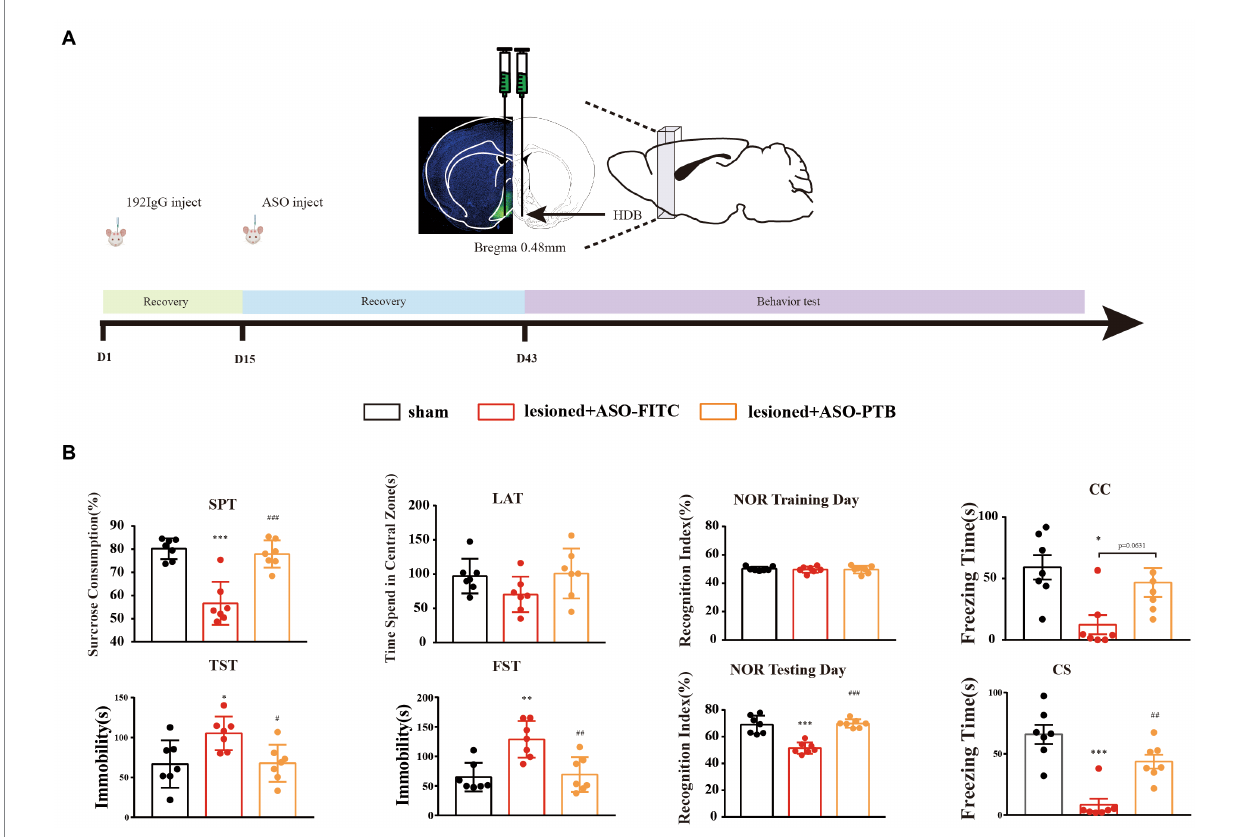
FIGURE 1 Conversion of astrocytes to neurons by ASO-PTB could relieve depressive-like behaviors and ameliorate cognition impairment phenotypes. (A) Experimental schedules. (B) The sucrose preference (one-way ANOVA, Tukey’s multiple comparisons test, F (2,18) = 25.26, *** p < 0.001, ### p < 0.001, n = 7); immobility time in the TST (one-way ANOVA, Tukey’s multiple comparisons test, F (2,18) = 5.42, * p = 0.0254, # p = 0.0293, n = 7) and FST (one-way ANOVA, Tukey’s multiple comparisons test, F (2,18) = 11.05 ** p = 0.0015, ## p = 0.0027, n = 7); the time spent in the central area in LAT (one-way ANOVA, Tukey’s multiple comparisons test, F (2,18) = 2.2, compared to the sham group, p = 0.2362, compared to the ASO-FITC group, p = 0.1615, n = 7); the cognitive memory about the time to explore novel object in NOR (one-way ANOVA, Tukey’s multiple comparisons test, F (2,18) = 30.76, *** p <